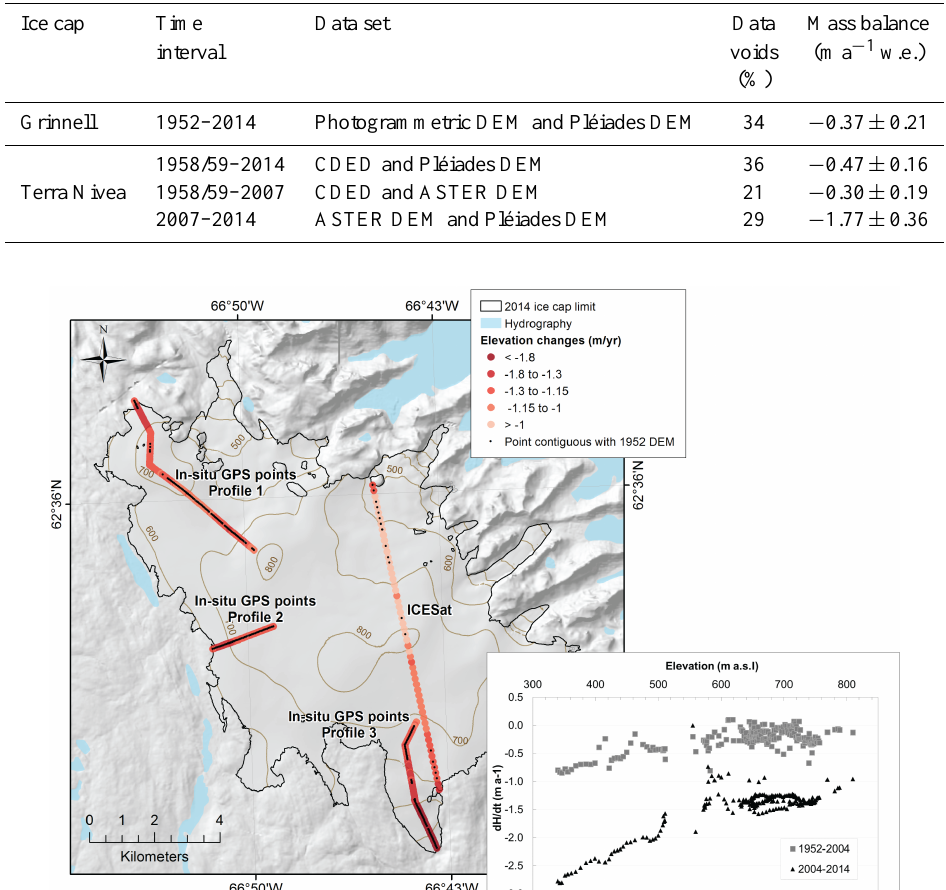
Figure 4. Elevation change rates (ma − 1 ) on Grinnell Ice Cap between March/April 2004 (ICESat and in situ GPS points) and August 2014 (Pléiades DEM). Bottom right graph shows historical (1952–2004) and recent (2004–2014) rates of elevation changes along the 203 points contiguous with the 1952 DEM (represented as black dots on the